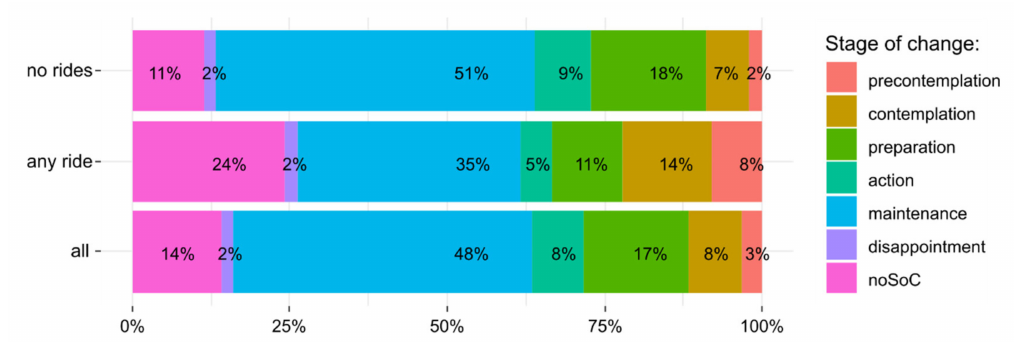
Figure 2. Classification of participants according to the stage-of-change. “noSoC” denotes participants who provided insu ffi cient information for stage-of-change allocation.